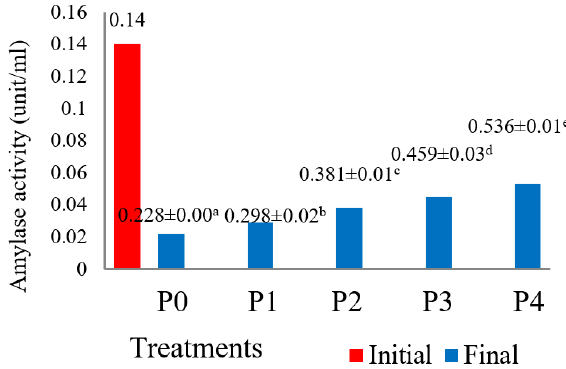
Figure 3. Changes in amylase enzyme activity in the intestinal of silver pompano. P0 = FFM 0%, P1 = FFM 10%, P2 = FFM 20%, P3 = FFM 30%, and P4 = FFM 40%.